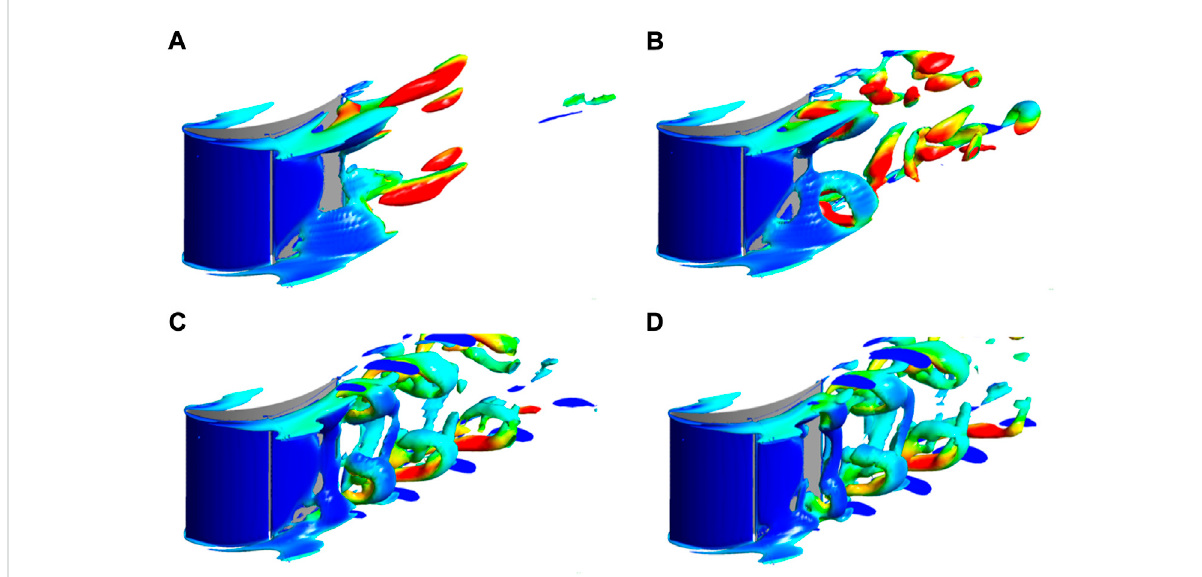
FIGURE 7 Instantaneousvortexstructuresofthecascadeinthecontrolwithdifferentoscillationamplitudes(Q= 2 × 10 6 ,0.39 (cid:1) Z ,m s =1.77%,f=1,000 Hz, α = 25 o , i = 0 o ). (A) Δ m Δ m Δ m s = 0.00%, BLS; (B) s = 5.98%, BLOS; (C) s = 48.71%, BLOS; and (D)